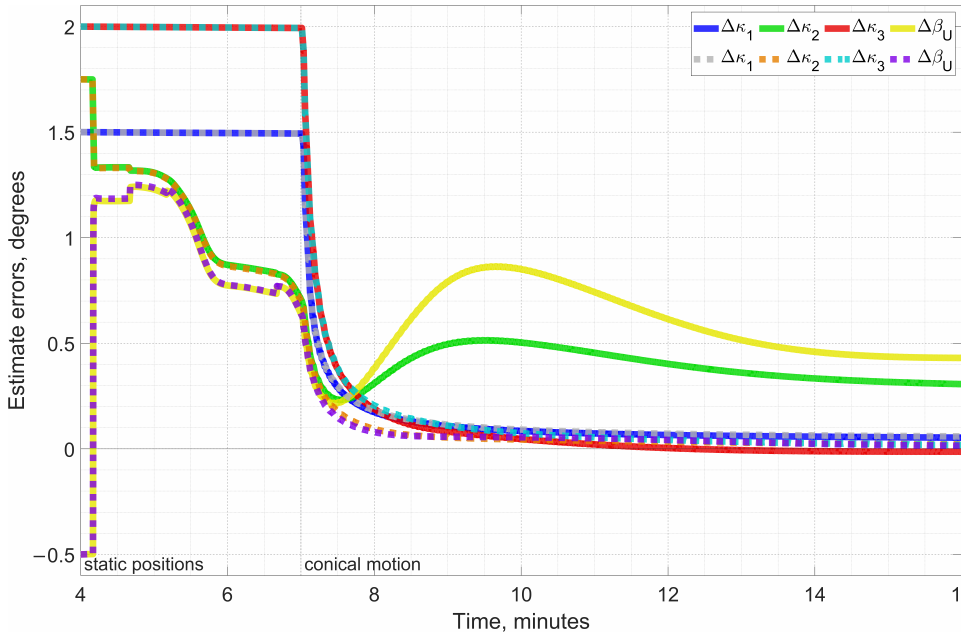
Figure 5. Errors of κ b , β U estimates using ( a ) conventional Euler attitude integration (solid lines), and ( b ) our algorithm described in Section 2.1.2 (dashed lines). Replacing the attitude integration algorithm alone changes the convergence from non-existing to very good.